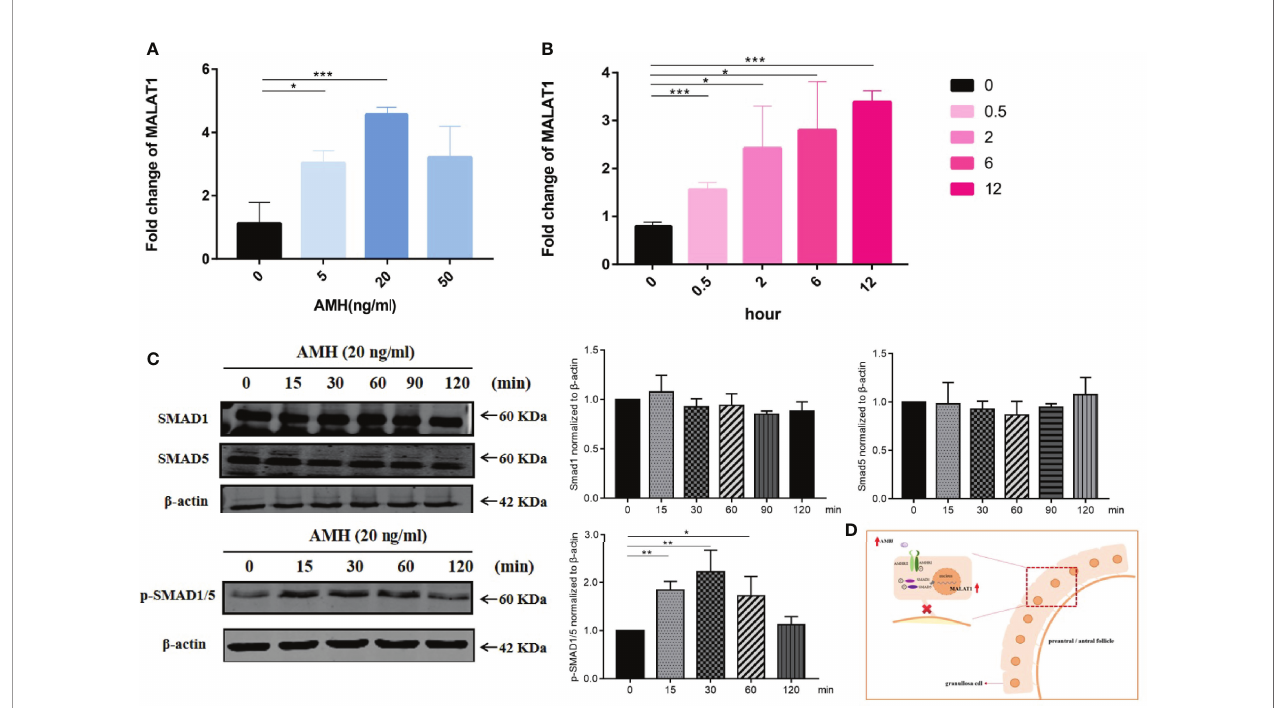
FIGURE 3 | AMH upregulated SMAD signal pathway and MALAT1 expression. (A) KGN cells were treated with a range of AMH dose (5 to 50 ng/ml) for 24 h. The expression level of MALAT1 was determined by RT-qPCR (* p < 0.05; *** p < 0.01). (B) Graph showing the expression level of MALAT was gradually increased in KGN cells treated with 20 ng/ml AMH and was determined by RT-qPCR (* p < 0.05; *** p < 0.01). (C) Representative Western blot images using anti-pSMAD 1/5, anti-SMAD1, and anti-SMAD5 antibodies on total protein lysates extracted from KGN cells treated with AMH (20 ng/ml) for 120 minutes. Quantitative analysis of protein bands was performed by ImageJ. * p < 0.05; ** p < 0.01. (D) Scheme graph of MALAT-induced proliferation decreased in granulosa cells. AMH upregulated the expression of MALAT via activing phosphorylated SMAD1/5, leading to suppress granulosa cell.